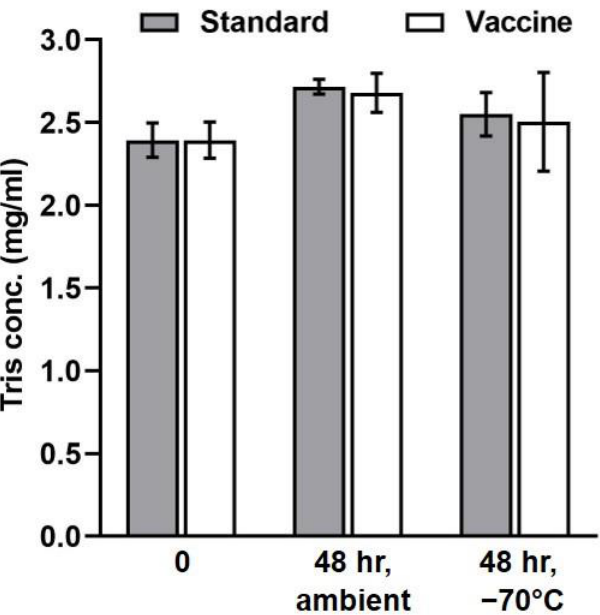
Figure 6. Stability of TRIS-IBCF at ambient temperature for 48 hr. A standard solution and a vaccine preparation were derivatized in triplicate. The derivates were split into two equal samples stored at − 70 ◦ C and ambient temperature. The derivates were then analyzed by RP-LC-ESI-MS/MS, and the TRIS concentration in these samples was determined both at zero time and after 48 h. Error bars are ± 1 standard deviation.